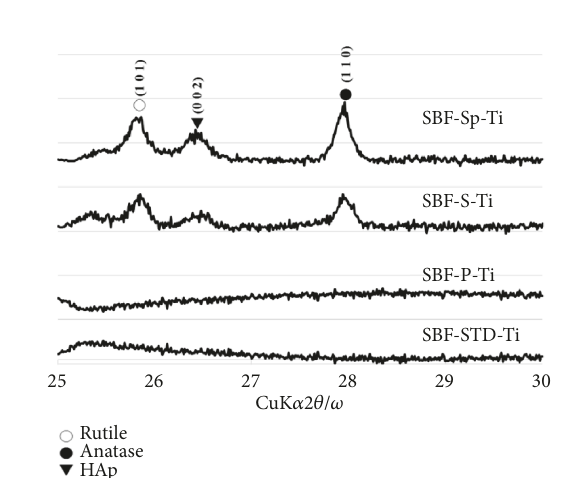
Figure 8: XRD patterns of Ti samples after immersion in SBF for 1 day.